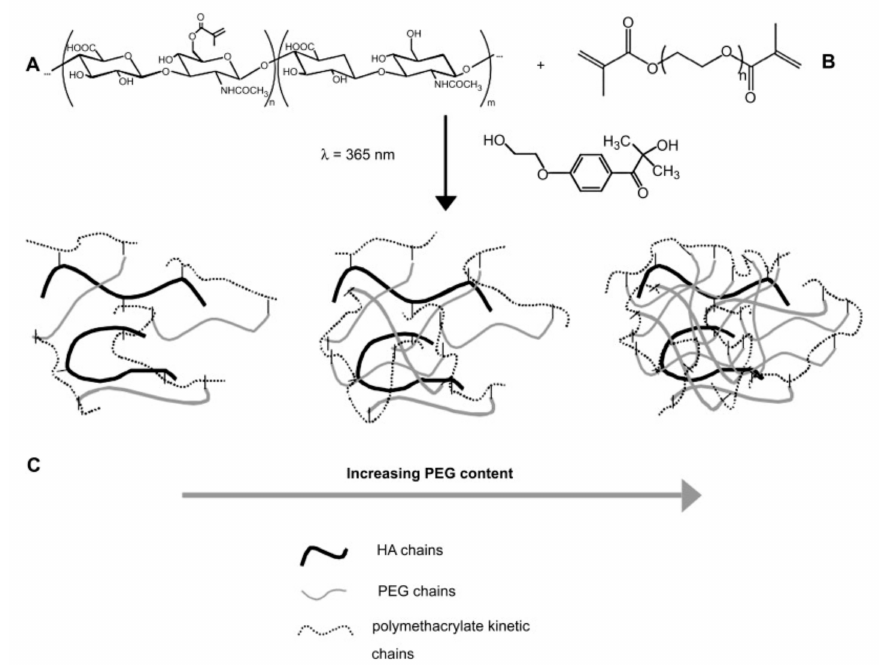
Figure 8. ( A ) Multimethacrylated HA with m + n (m + n ≈ 10,000) repeat units (Mr ≈ 400 Da). In this study, ~1 in 5 disaccharide units was functionalized with a methacrylate group. ( B ) Dimethacrylated PEG chains with n repeat units (Mr ≈ 44, n ≈ 105) were end-capped with methacrylate groups. ( C ) Hydrogel networks formed by radical initiated chain copolymerization of HA with varying amounts of PEG. Primary radicals were produced by the dissociation of the photoinitiator, 1-[4-(2-hydroxyethoxy)-phenyl]-2-hydroxy-2-methyl-1-propanone, in the presence of UV light (l = 365 nm)